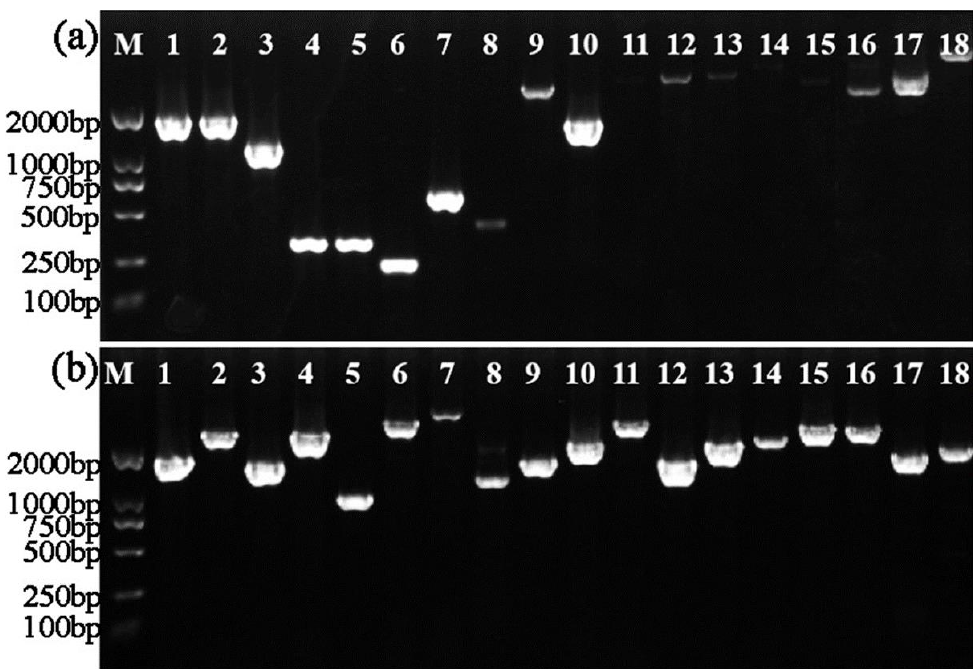
Figure 3. A single band with the expected size ranging from 176 bp to 4803 bp was observed